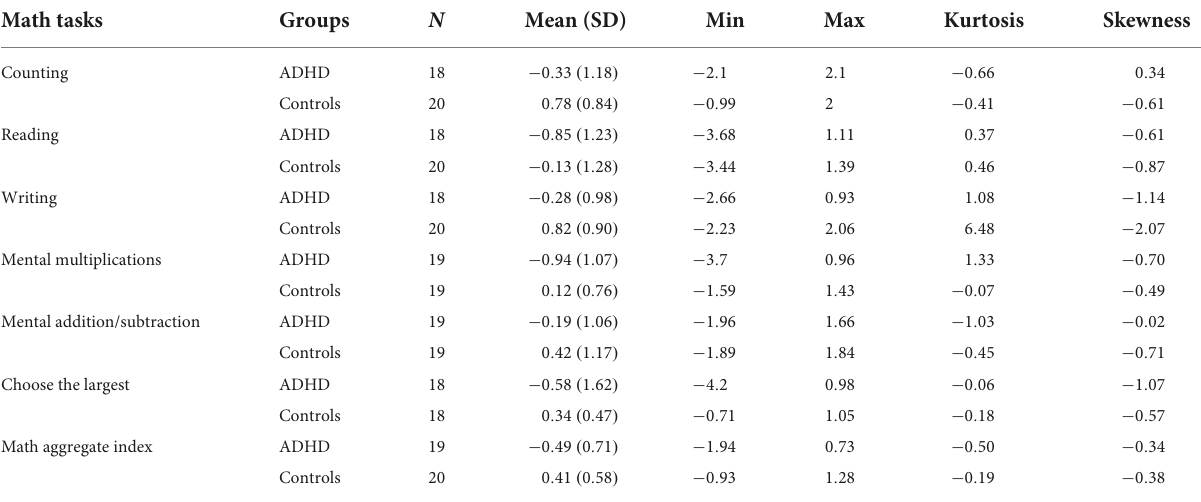
TABLE 2 Descriptive statistics on math abilities ( z